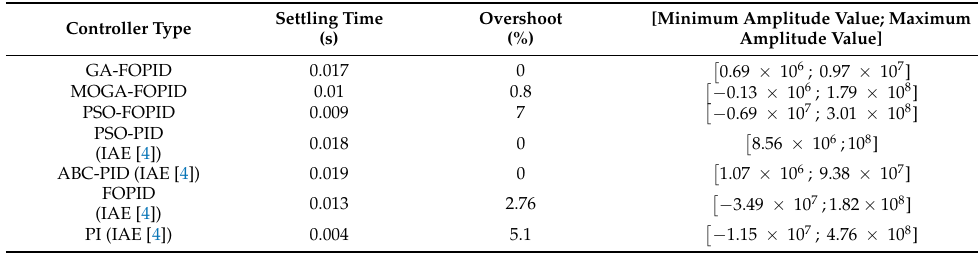
Table 6. Step reference results.